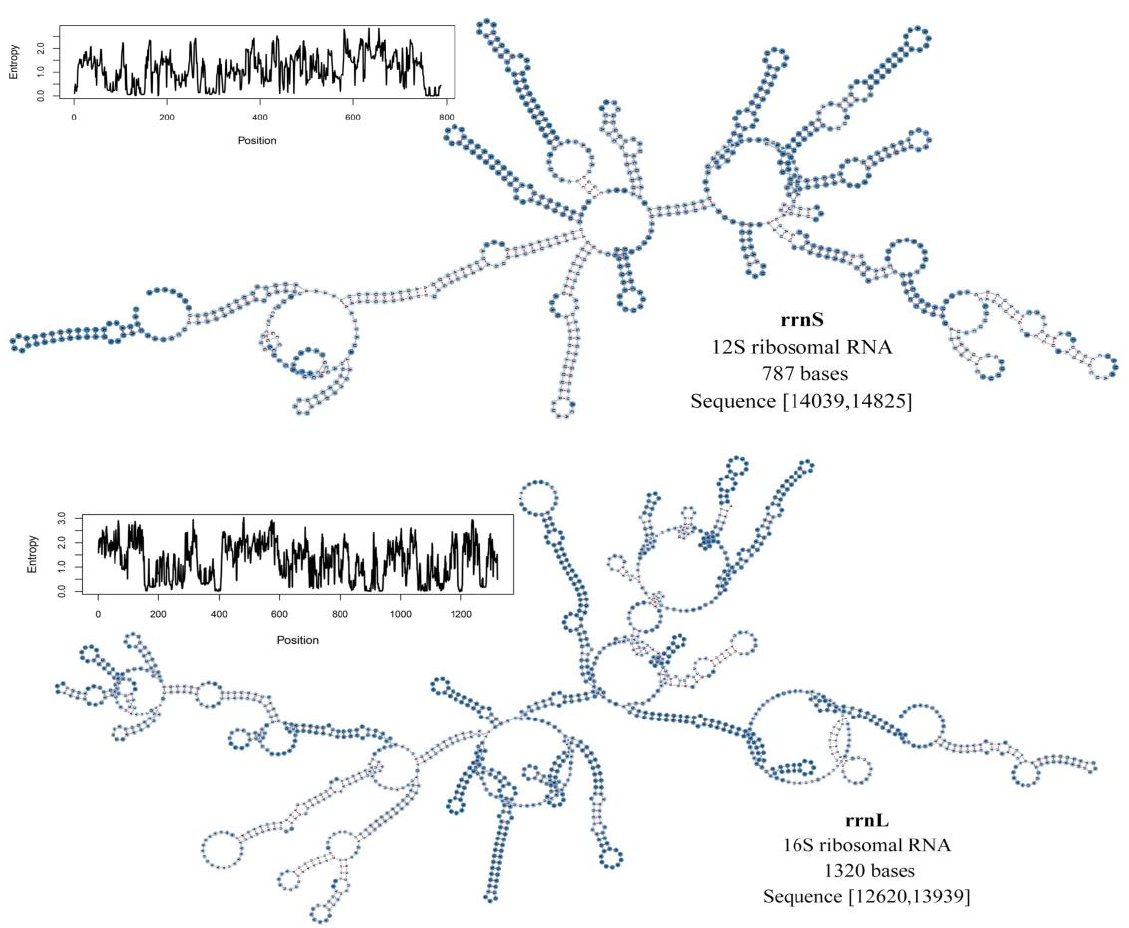
Figure 6. Secondary structure of rrnS and rrnL mt genome of P. casei .